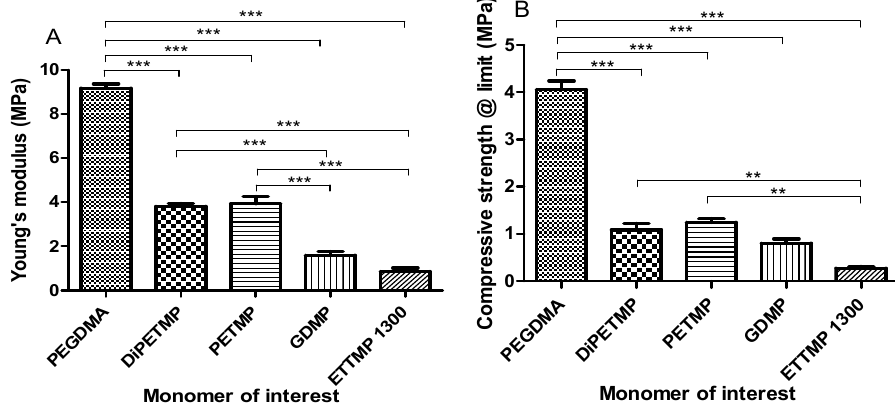
Figure 4. The compressive properties of PEGDMA-thiol hydrogels showing ( A ) the compressive modulus at limit (MPa) and ( B ) Young’s modulus (MPa).